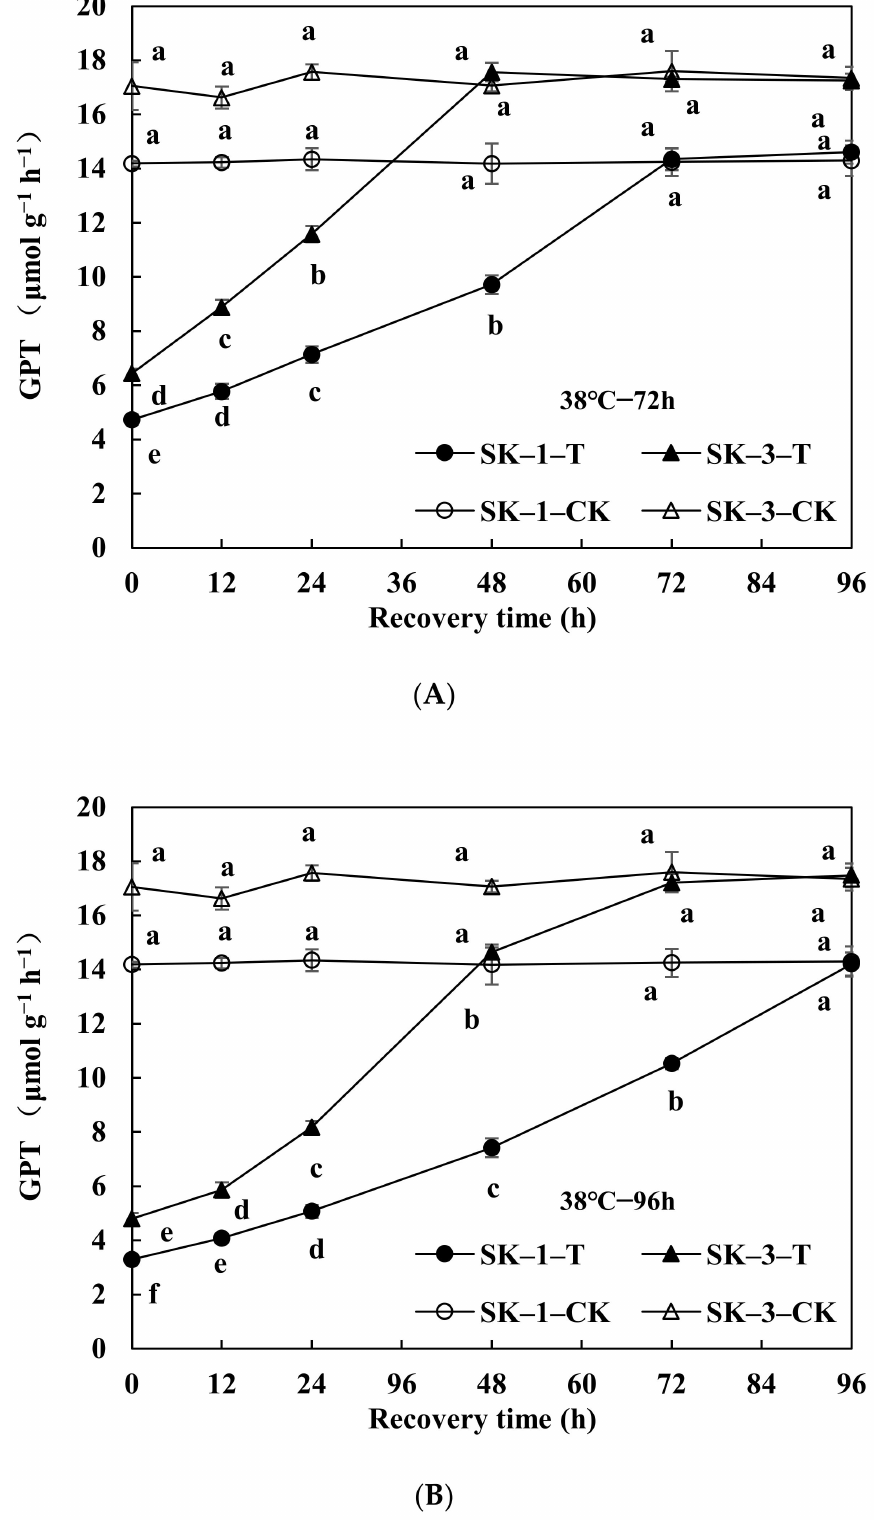
Figure 5. Changes in GPT activities in squares of Bt cotton after 72 h ( A ) and 96 h ( B ) high-temperature stress termination. GPT activity at the recovery time with different lowercase letters is significantly different from the control at p < 0.05 under the same high-temperature stress duration for the same cultivar. T—treatments for 72 h ( A ) and 96 h ( B );